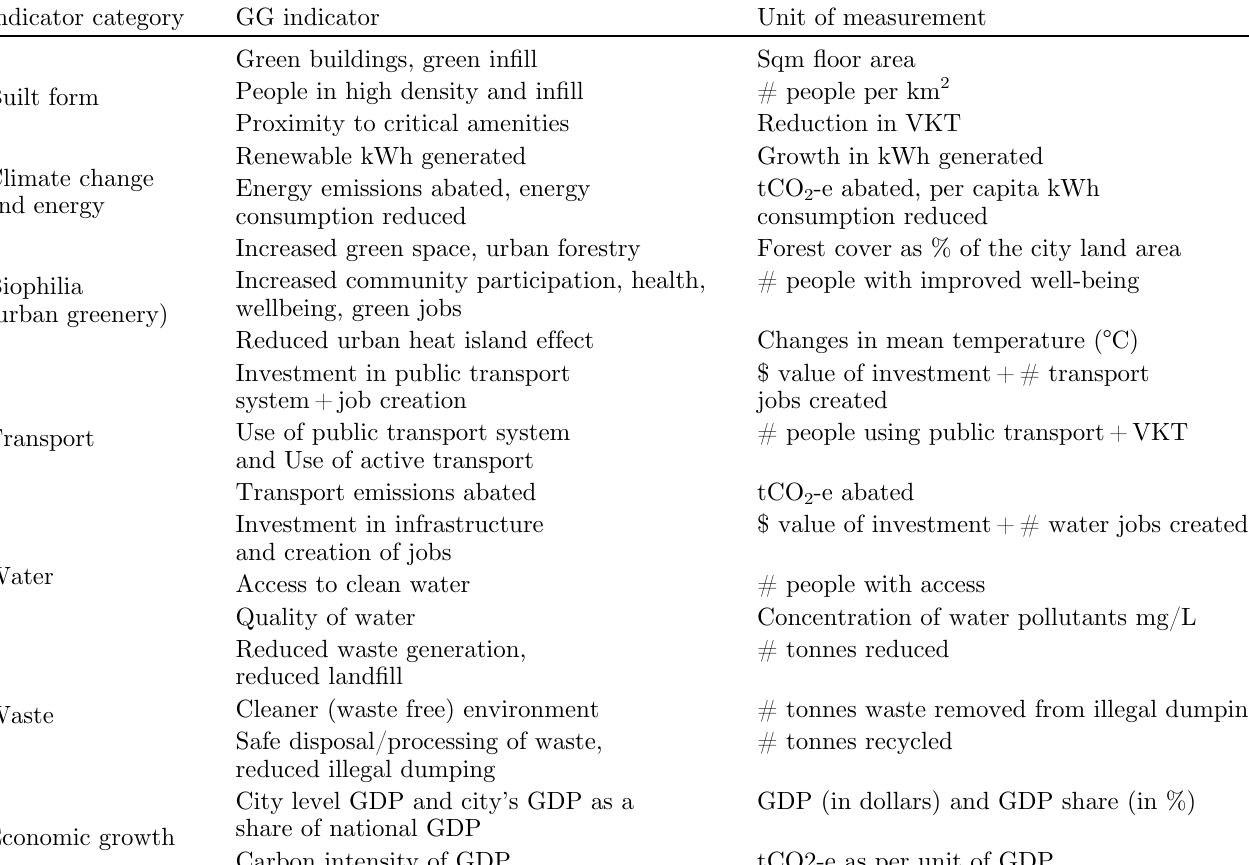
Table 1. Proposed Green Growth indicators for Australian cities. Indicator